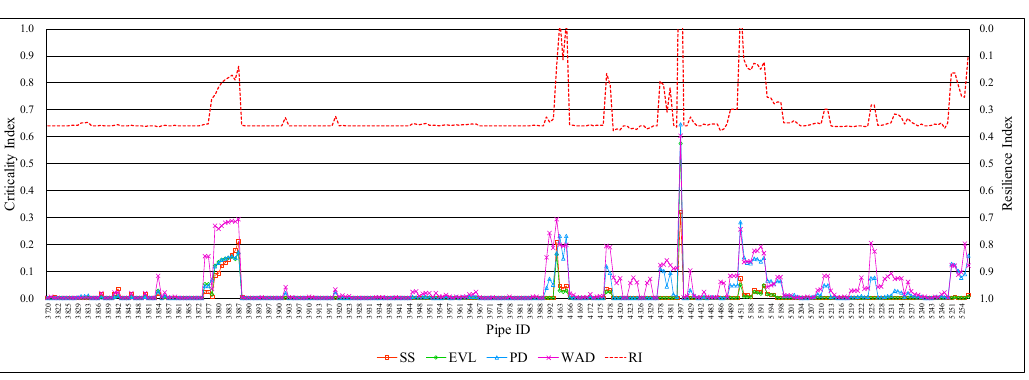
Figure 11. Comparison of the four criticality indexes with Resilience Index (RI) for Network 1.